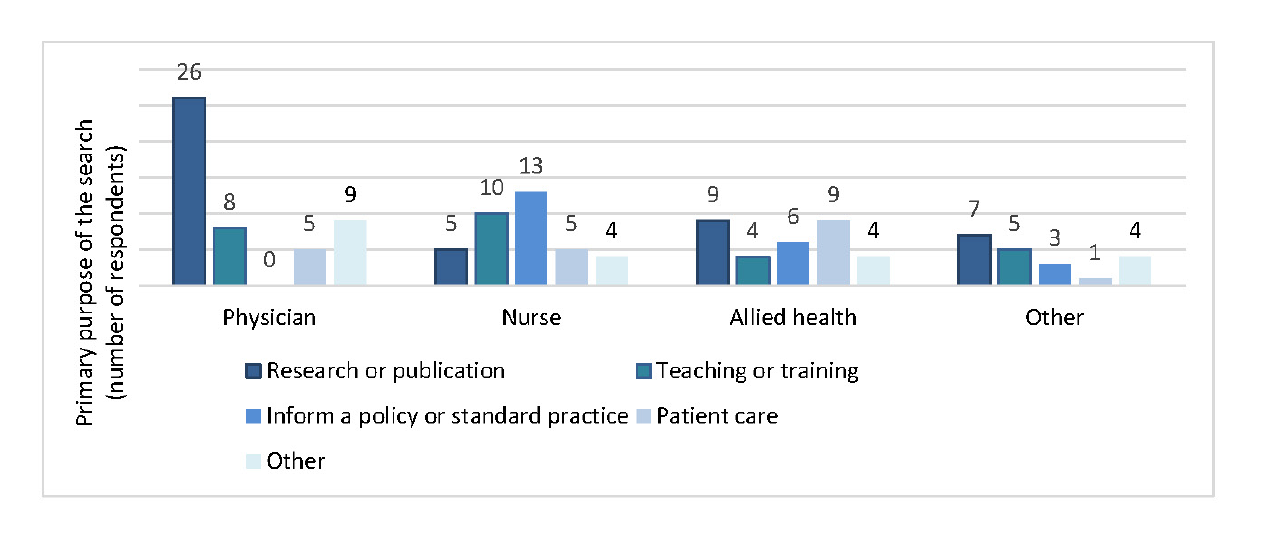
Figure 1 Primary purpose of the search request by professional